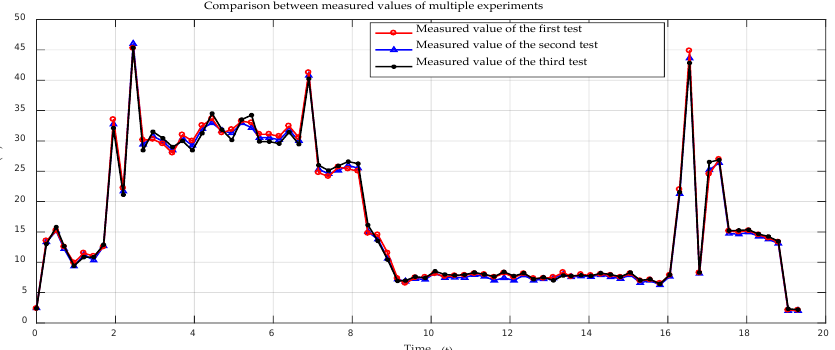
Comparison between measured values of multiple experiments Measured value of the first test Measured value of the second test Measured value of the third test